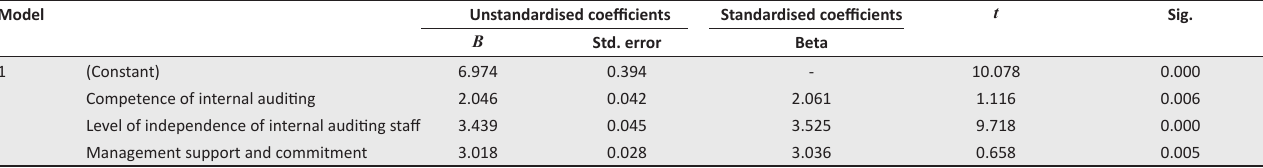
TABLE 7: Variable coefficients of the regression model.